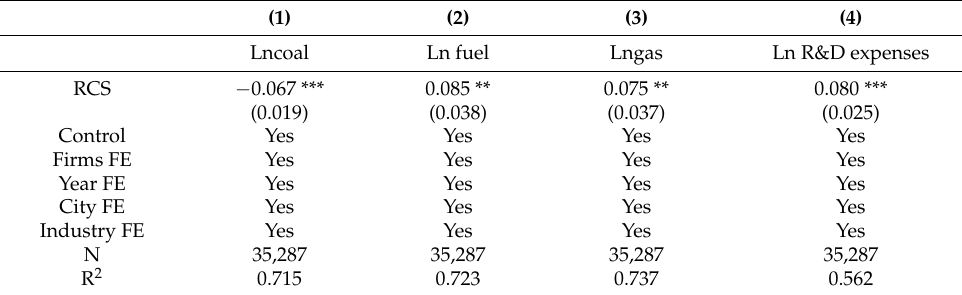
Table 6. Mechanism